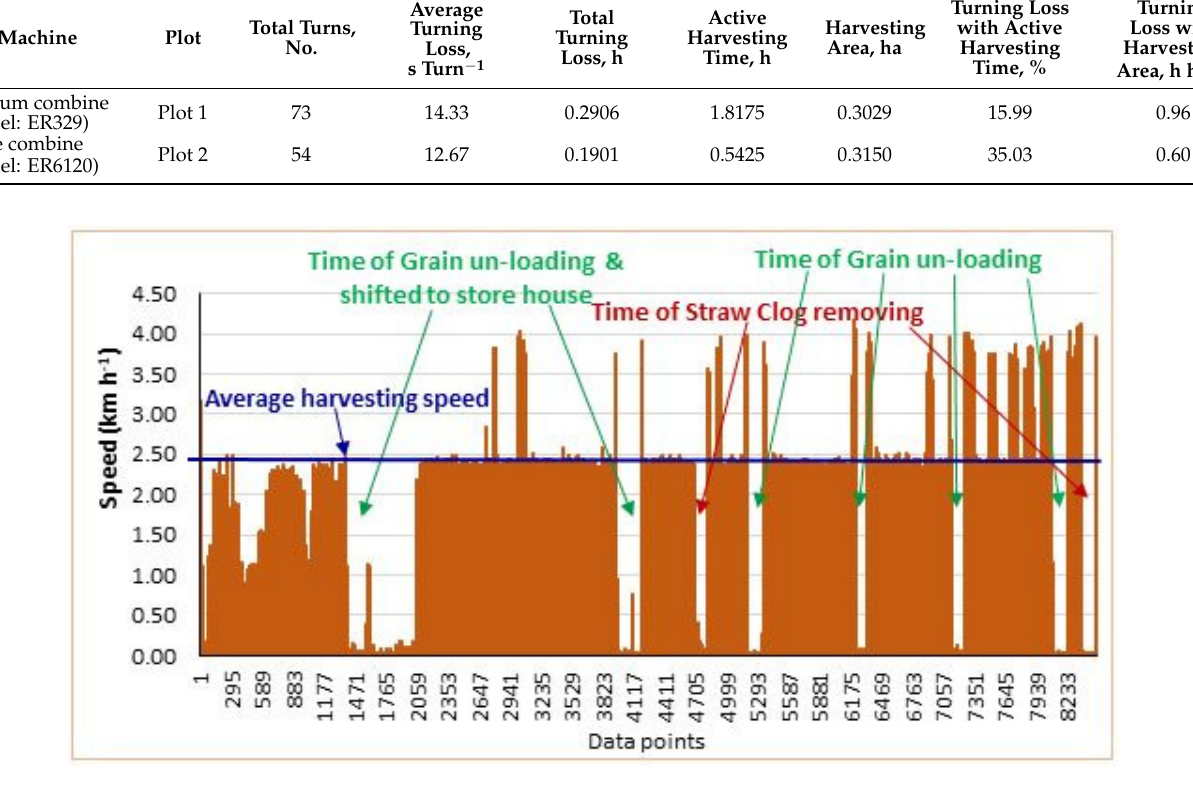
Figure 6. Different speeds and idle times during harvesting at Plot 1 by medium combine.